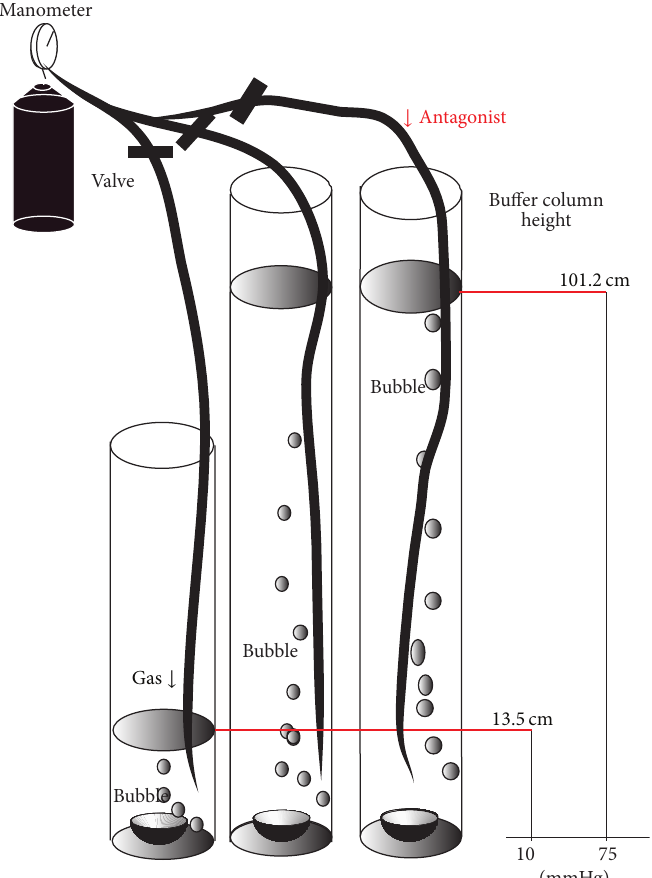
Figure 2: Outline of the present experiments. Eyecups preparations were sunken to the bottom of a glass cylinder with different heights. Each glass cylinder was filled with incubation buffer at 30 ∘ C for 24hours. The buffer was bubbled with 95% O 2 -5% CO 2 Hydrostatic pressure at the bottom of the cylinder was calculated to be 10mmHg and 75 mmHg when a CSF was added to a height of 13.5cm and 101.2cm, respectively. Glutamate receptor antagonists or agonists were added to the buffer during some